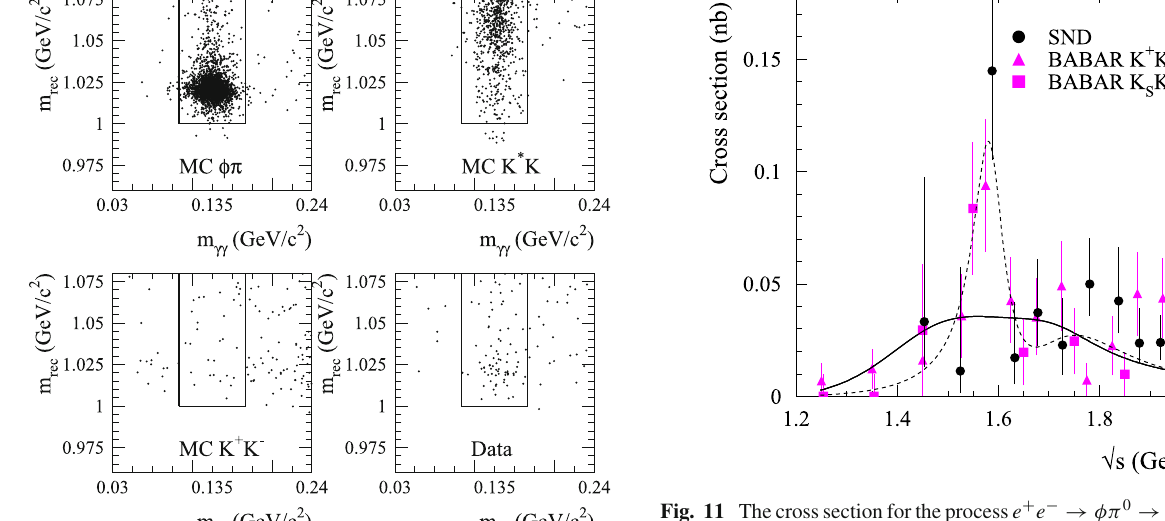
Fig. 11 The cross section for the process e + e − → φπ 0 → K + K − π 0 obtained in this experiment in comparison with the two BABAR mea- surements [3,4]. The solid and dashed curves represent the results of the fit in Models I and II, respectively nal events. The coefficients k b and k s are determined from